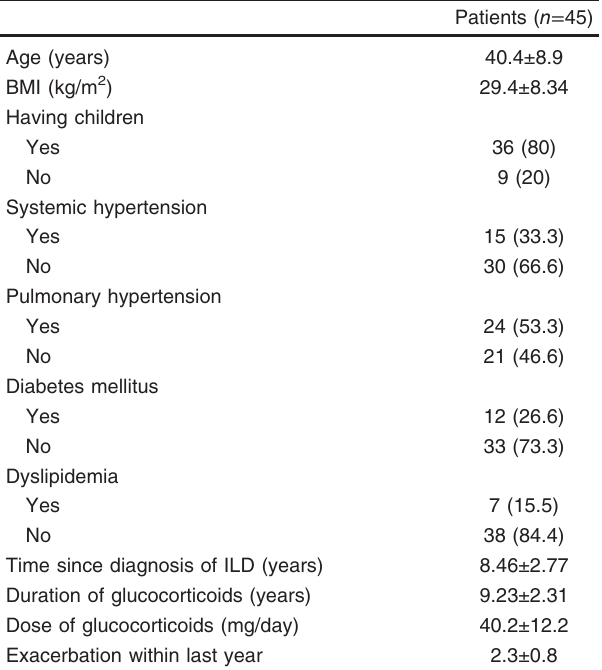
Table 1 Sociodemographic characteristics of the studied participants with interstitial lung disease ( n =